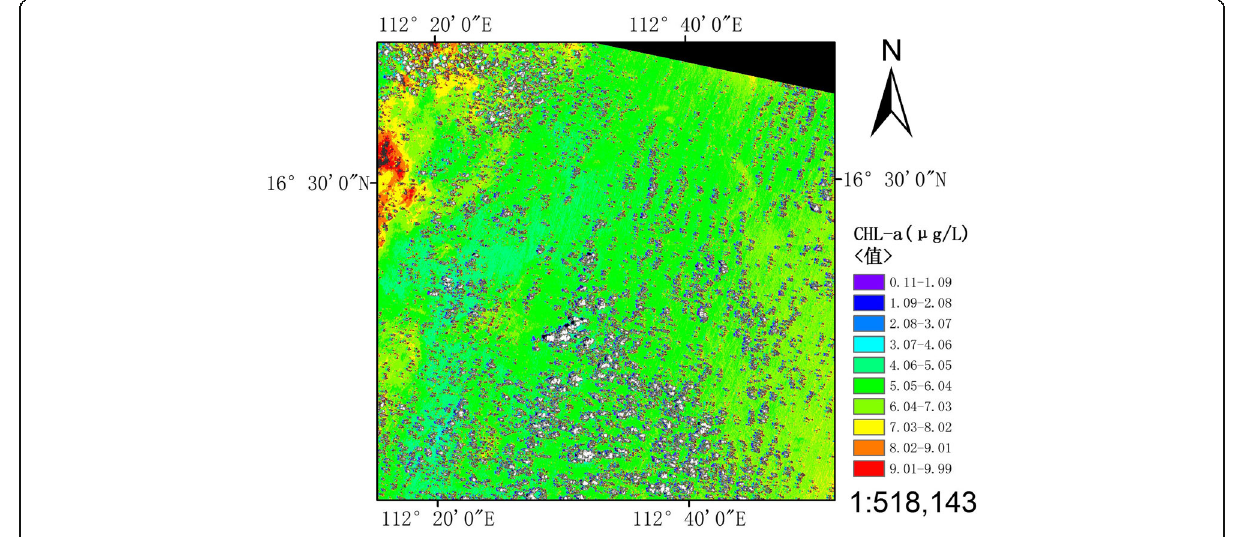
Fig. 16 The distribution in typhoon “ Mujigae ”